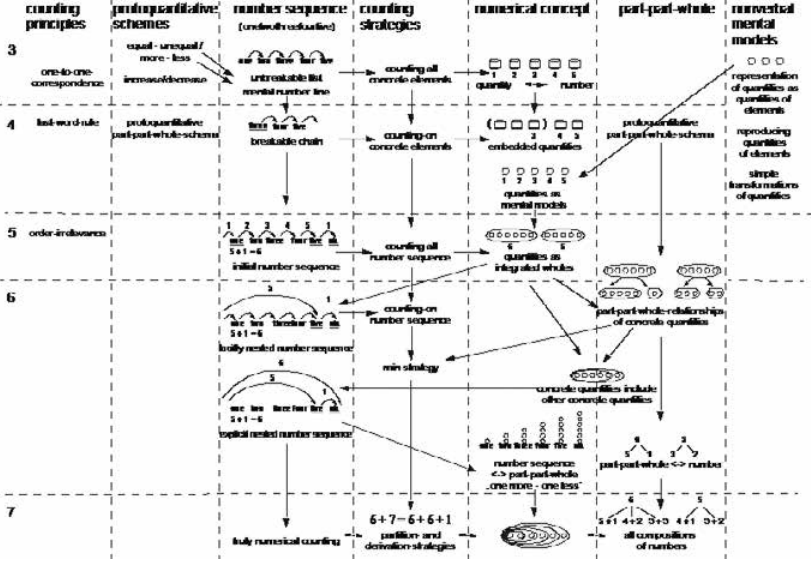
Figure 2: Development of numerical